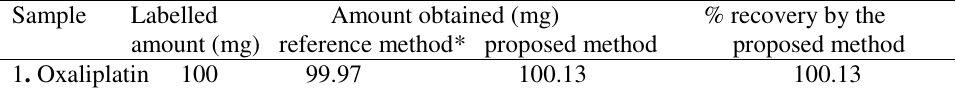
Table 2. Assay of Oxaliplatin in Pharmaceutical